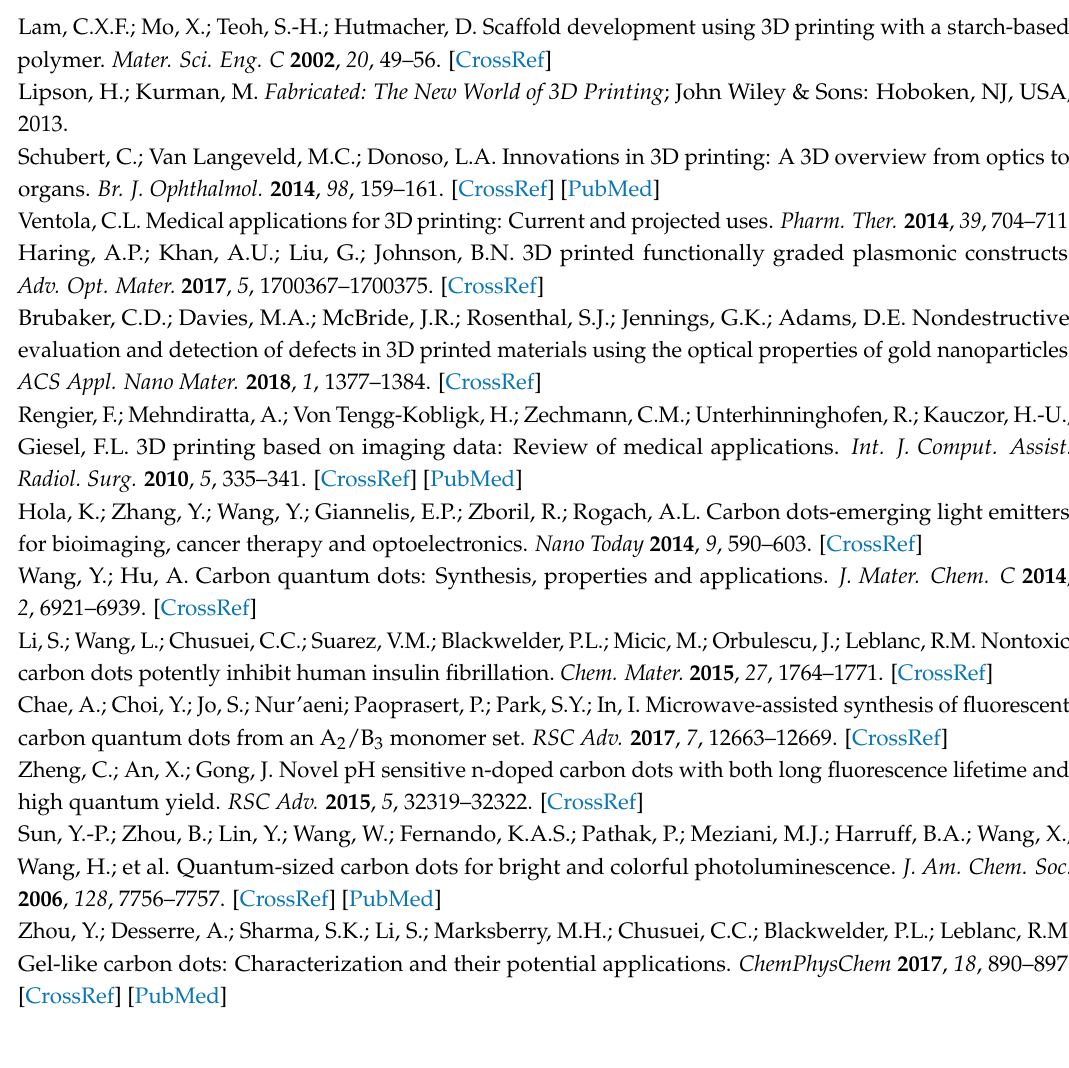
Figure S1: The UV/vis absorption spectra of O-CDs dispersed in various solvents, Figure S2: O-CDs in aqueous medium mixed with SPA with different mass ratio (1:500, 1:100 and 1:50, from left to right) before and after the evaporation of water; The fluorescence spectra of O-CDs mixed with SPA with different ratios under an excitation wavelength of 400 nm, Figure S3: The fluorescence emission spectrum of SPA powder and O-CDs embedded in SPA, Figure S4: O-CDs embedded in SPA in different solvents (4 mg/mL). (From left to right: water, methanol, acetone, THF), Figure S5: TEM image of SPA particles alone, Figure S6: The stereolithography file for